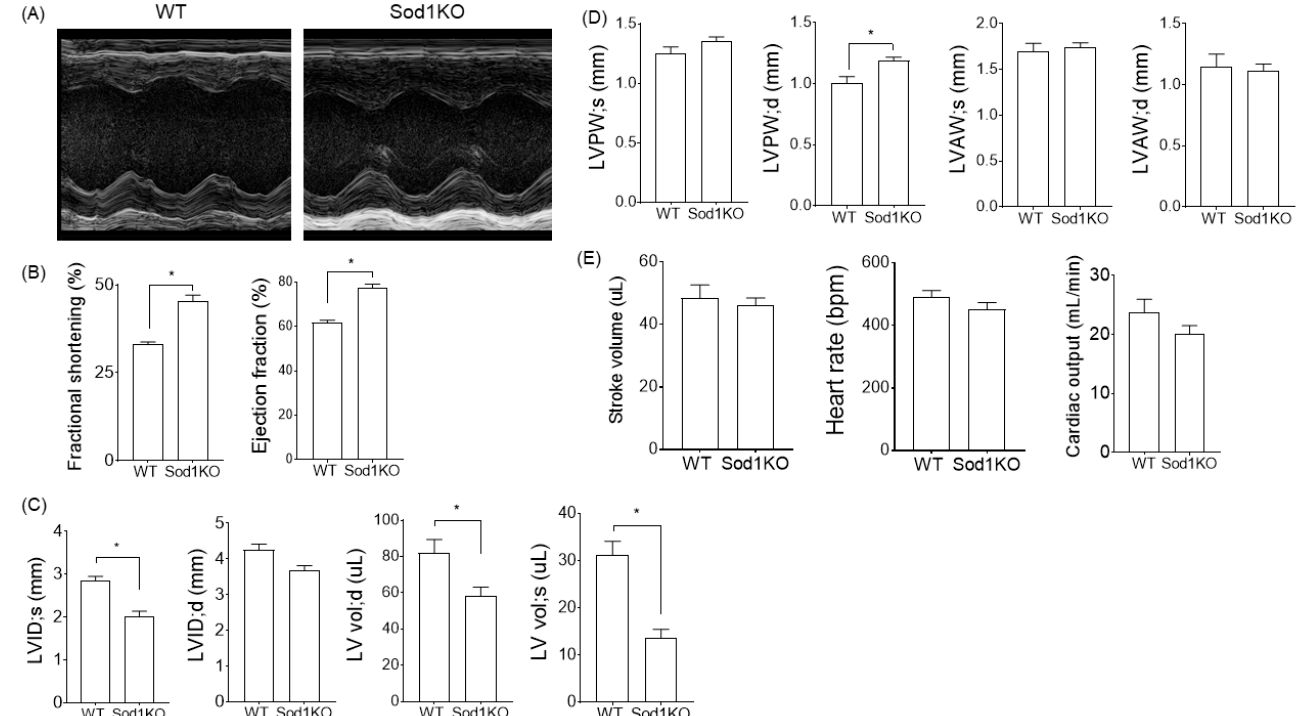
Figure 2. Sod1KO mice exhibited increased systolic function with compensatory remodeling. 6–8-month-old male mice were anesthetized during the assessment. Heart rates were maintained between 400–500 bpm. ( A ) Representative M-Mode images of the short axis view of WT and Sod1KO hearts. ( B ) Ejection fraction and fractional shortening in WT and Sod1KO mice. ( C ) Left ventricular internal diameter (LVID) and left ventricular volume (LV Vol) at peak systole and diastole in WT and Sod1KO mice. ( D ) Left ventricular posterior wall thickness (LVPW) at peak systole and diastole in WT and Sod1KO hearts. ( E ) Heart rate, stroke volume, and cardiac output in Sod1KO remained similar to wildtype peers. Abbreviations: LV = left ventricle; s = systole; d = diastole; LVID = LV internal diameter; LVAW = LV anterior wall thickness; LVPW = LV posterior wall thickness. n = 5–8. Data are mean ± SEM. * p < 0.05.